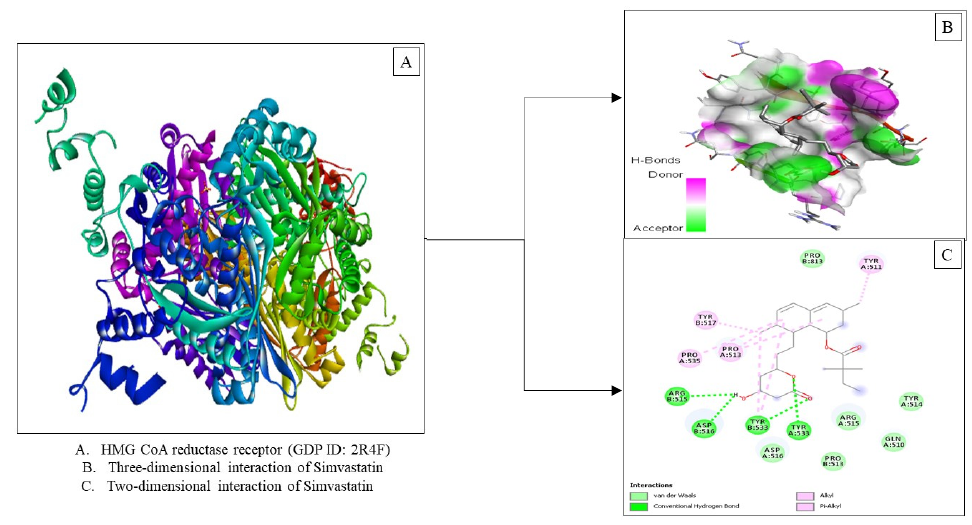
Figure 4. Visualization of the HMG-CoA reductase receptor docking (PDB ID: 2R4F) with simvastatin.